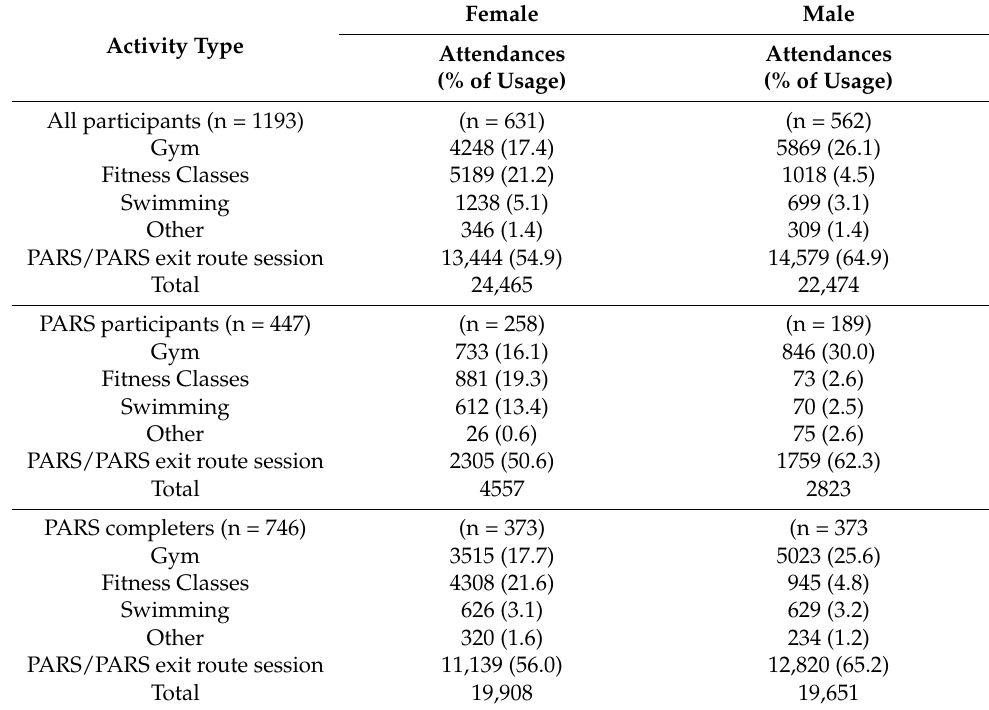
Table 3. Attendance and activity choices by sex.